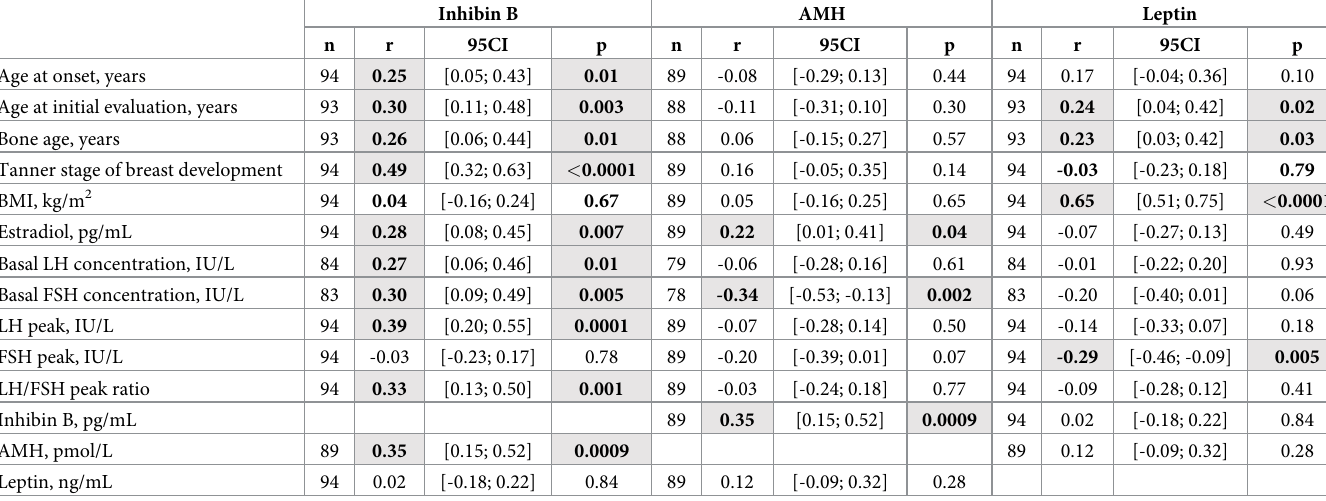
Table 2. Correlations between serum inhibin B, AMH, and leptin concentrations and the characteristics at initial evaluation of girls with